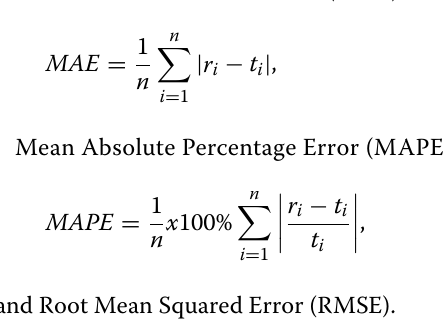
We use Mean Absolute Error (MAE)